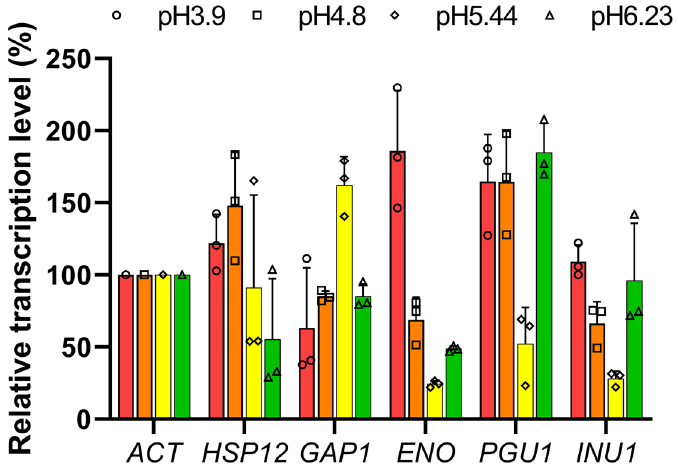
Figure 4. Relative transcription levels of HSP12 , GAP1 , ENO , PGU1 , and INU1 compared with those of ACT at pH 3.9, pH 4.8, pH 5.44, and pH 6.23 in culture. The data are presented as the mean and standard deviation of three replicates. This image was created by using GraphPad Prism (version 8.2.1; https:// www. graph pad. com/ scien tific- softw are/